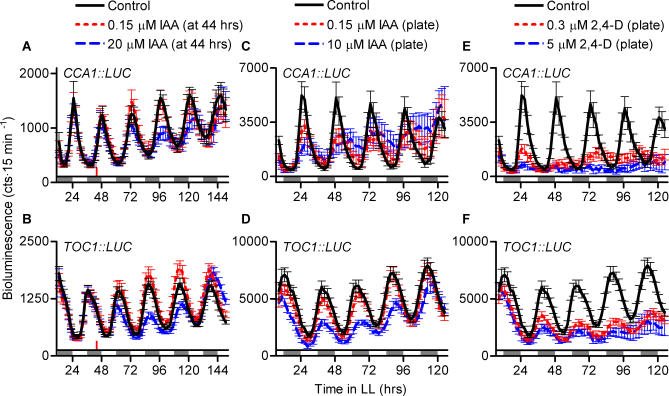
Auxin Affects Rhythmic Expression of Clock Genes in a Dose-Dependent MannerAverage luciferase activity of CCA1::LUC (A, C, E) and TOC1::LUC (B, D, F) plants (n = 9–12) with standard error of the mean in response to exogenous auxin is presented. Seedlings were sprayed with the indicated concentrations of IAA after 44 h in continuous light (red tick mark) (A) and (B), or 1–2 h prior to the start of imaging, were transferred to growth medium containing the indicated concentrations of IAA (C) and (D) or 2,4-D (E) and (F). See Table S5 for statistical analyses. Plants were entrained for 6 d in 12-h white light/12-h dark photoperiods before being imaged in constant red light. (C) and (D) and (E) and (F) show representative data from three and two independent experiments, respectively.